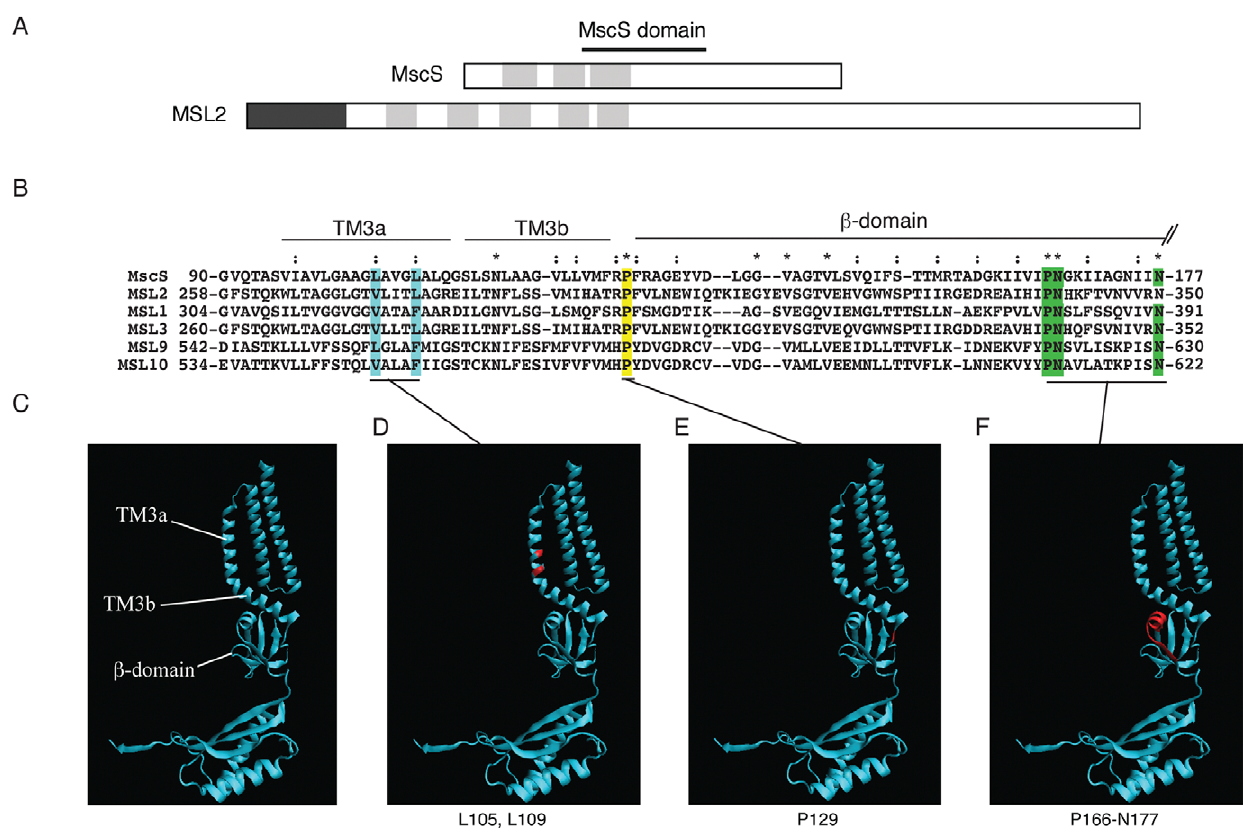
Figure 1. Identification of conserved motifs selected for functional analysis of MSL2. (A) Topology of MscS and predicted topology of MSL2. Dark grey box, chloroplast transit peptide. Light grey boxes, transmembrane helices. (B) The MscS domain according to an alignment of the conserved region of E. coli MscS and five representative MscS-Like (MSL) proteins from A. thaliana . Double dots and asterisks indicate similar and conserved residues, respectively. Sequences corresponding to TM3a, TM3b, and the ß-domain of MscS are indicated by lines [21]. (C–F) Ribbon diagram of a single subunit of MscS from the revised Rees crystal structure (PDB 20AU [13,21]). The three conserved motifs functionally characterized in this report are highlighted in blue, (MscS L109, MSL2 V273/L277); yellow (MscS P129, MSL2 P297); and green (MscS P166/N167/N177; MSL2 P339/ N340/N350) in (B) and shown in red in (D–F).